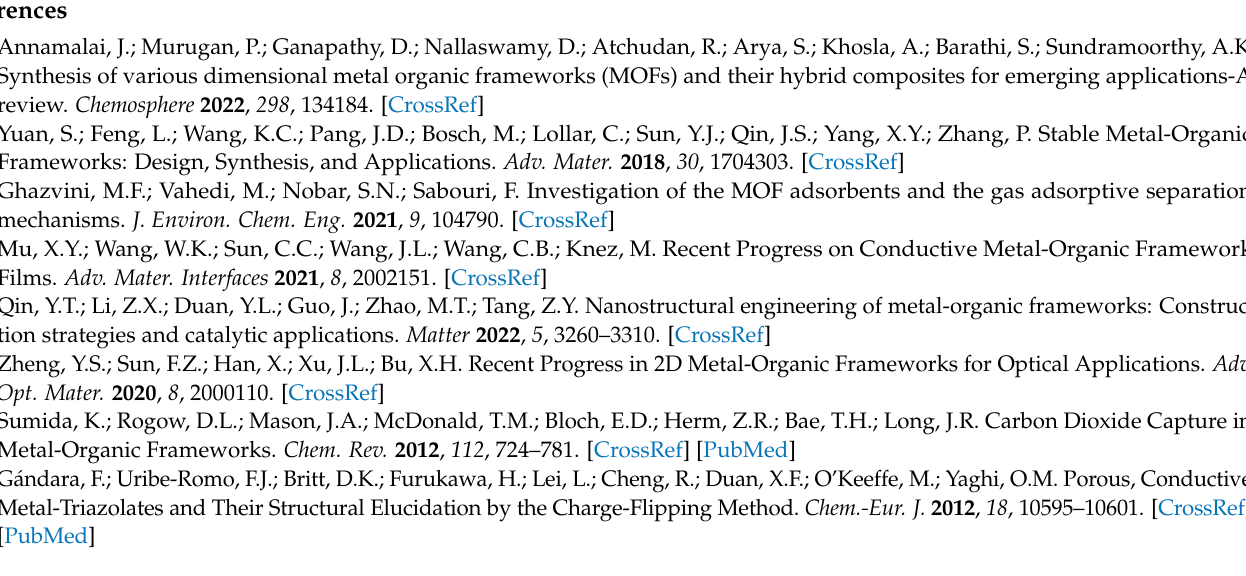
complex 2 . Figure S2: (a) Coordination environment diagram around the Zn(II) center in 5 ; (b) the 26-membered rings constructed by two bebiyh ligands and two Zn atoms; (c) 1D Zn/m-H 2 bdc chain; (d) the 2D layer structure of 5 ; and (e) schematic view of the 2D topology network for 5 . Figure S3: (a) coordination environment diagram around the Cd(II) center in 6 ; (b) 1D Cd/bebiyh chain; (c) 1D Cd/5-tbia chain; (d) 2D layer structure of 6 ; and (e) schematic view of the 2D topology network for 6 . Figure S4: Photoluminescent emission spectrum of the free H 2 X ligand, complexes 1 and 4 . Figure S5: Experimental (red) and simulated (black) PXRD patterns of complex 1 (a), 2 (b), and 4 (c). Table S1: Crystallographic data and structure refinement details for complex 1–6 a,b . Table S2: Table S2 Selected Bond Lengths (Å) and Bond Angles (deg) for 1–6 a